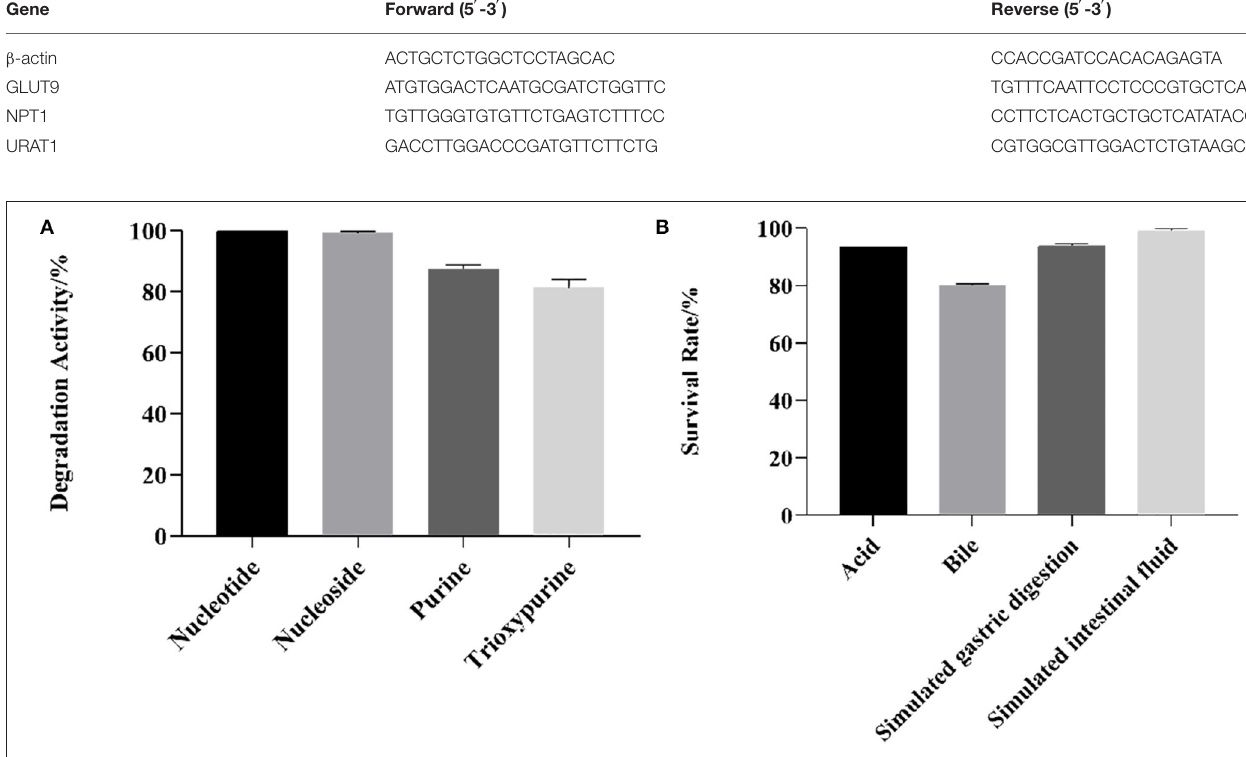
Changes in mRNA expression were calculated as a relative fold